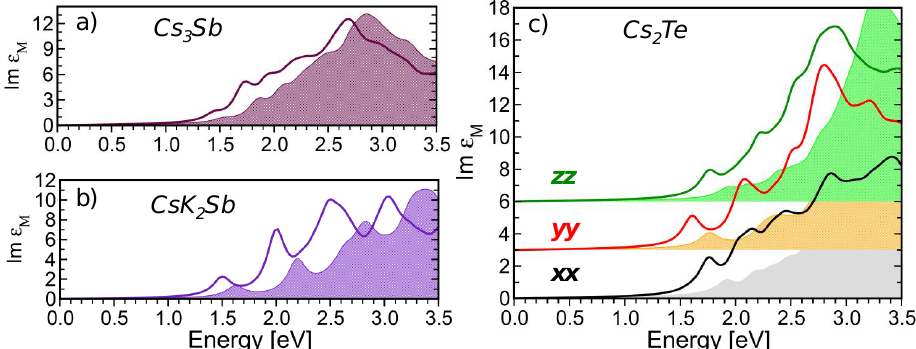
Figure 5. Optical absorption spectra of ( a ) Cs 3 Sb, ( b ) CsK 2 Sb, and ( c ) Cs 2 Te calculated, including and neglecting excitonic effects, by solving the full BSE (solid lines) or in the IQPA (shaded areas), respectively. In the spectra of Cs 3 Sb and CsK 2 Sb, all diagonal components of the dielectric tensor are equivalent. A Lorentzian broadening of 100 meV is applied to all spectra to mimic the excitation lifetime. The data reported in panel ( b ) coincide with those published in Reference